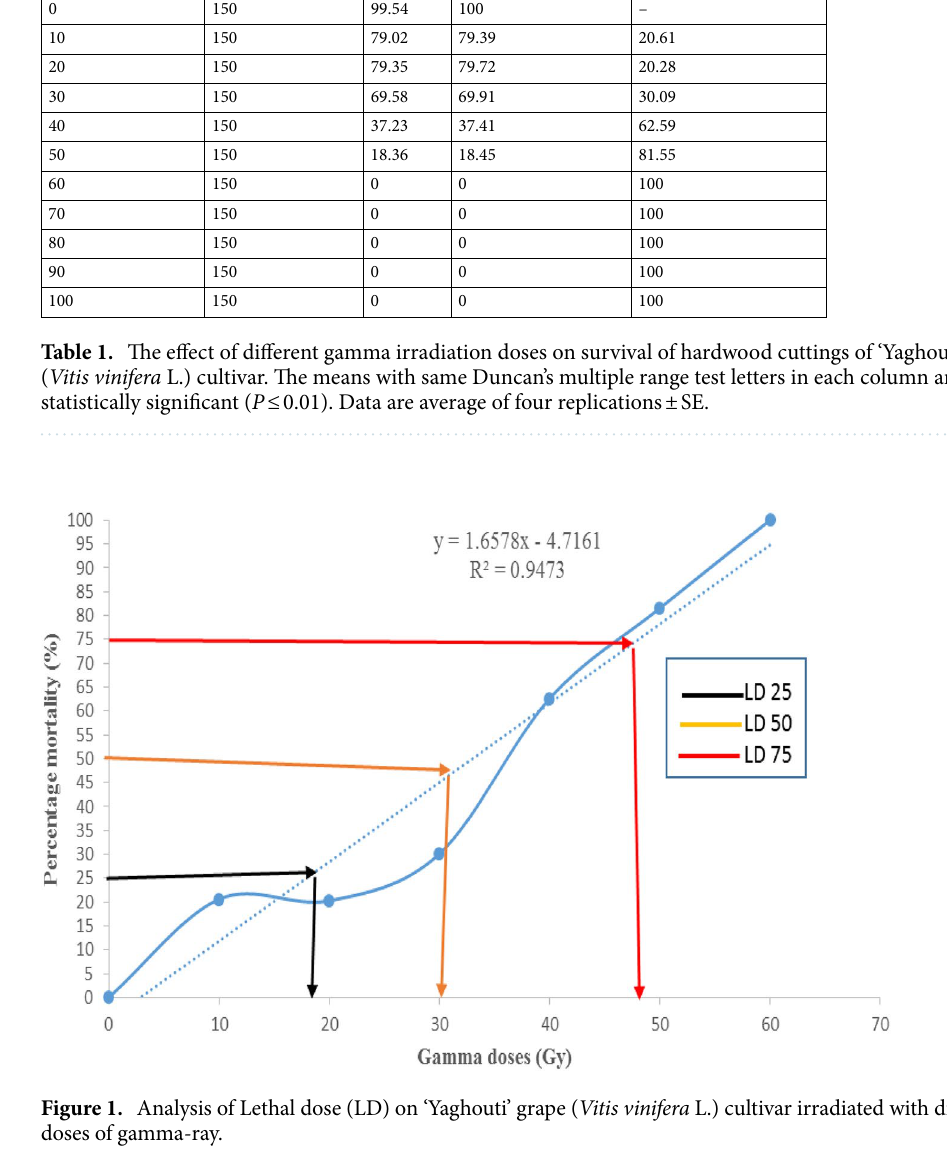
(Fig. 1). Thus, the Yaghouti cultivar can generate viable mutations in response to γ radiation dosages between 10 and 50 Gy; however, for preliminary mutagenesis investigations, 30 Gy seems to be the optimum dosage. Effects of mutagens on leaf traits. Effects of γ radiation on the M1 generation of the Yaghouti leaf characteristics are shown in Table 2. After γ radiation treatments, the Yaghouti grape leaf area ranged from 4475 mm 2 (0 Gy) to 1452 mm 2 (50 Gy). At 10–50 Gy, the leaf area declined to about 30% (10 Gy), 58% (20 Gy), 60% (30 Gy), 58% (40 Gy), and 67% (50 Gy) as compared to the control, although there were no significant differ- ences at 20, 30, 40, and 50 Gy. Due to γ irradiation showed a considerably significant difference in leaf width and length in grapes (Table 2). The maximum leaf length (80.79 mm) and width (77.53 mm) were seen in the control, but the minimum leaf width (45.60 mm) and length (45.83 mm) were observed in the 50 Gy (Table 2). Furthermore, the leaf length and width of the Yaghouti cultivar gradually decreased as dose levels rose, but there were no significant differences between high dose γ irradiation (30, 40, and 50 Gy). As a result of the γ-ray, the fresh-weight leaves of cv. Yaghouti significantly decreased compared to the control, whereas no significant dif- ferences were observed between 10 Gy and the control in the dry weight of leaves. All gamma radiation doses